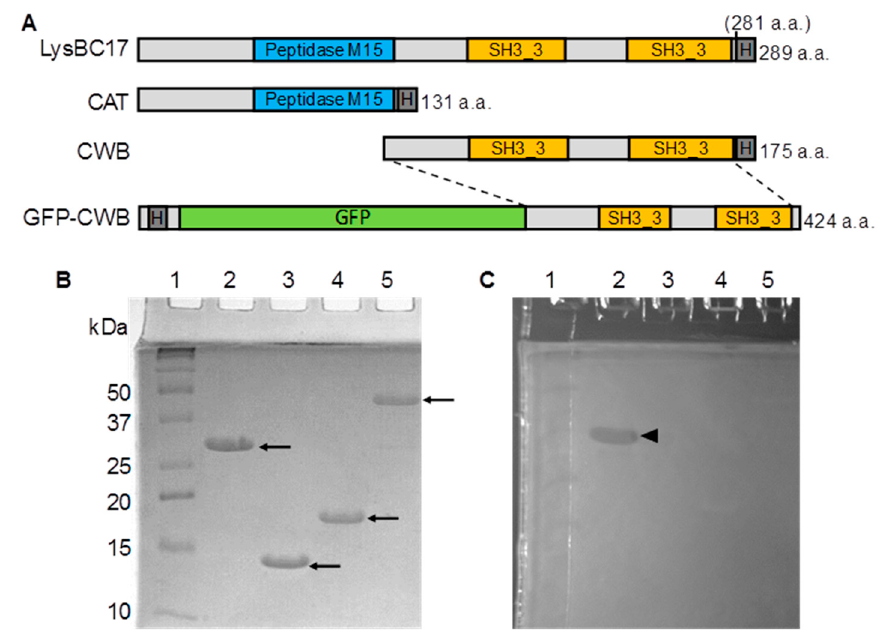
Figure 1. Schematics, sodium dodecyl sulfate polyacrylamide gel electrophoresis (SDS-PAGE), and zymogram of LysBC17, and its recombinant derivatives. ( A ) Schematics showing predicted domains of LysBC17, CAT (catalytic domain), cell wall binding domain (CWB), and the green fluorescent protein (GFP)-CWB proteins. ( B ) Coomassie-stained SDS-PAGE gel. Arrows indicate the purified proteins. ( C ) Zymogram gel with embedded B. cereus ATCC 14579 cells. Black triangle marks the clearing from LysBC17 activity on the embedded cells. Lanes for gels: lane 1, markers; lane 2, LysBC17 (32.5 kDa); lane 3, CAT (15.3 kDa); lane 4, CWB (19.0 kDa); lane 5, GFP-CWB (46.9 kDa).